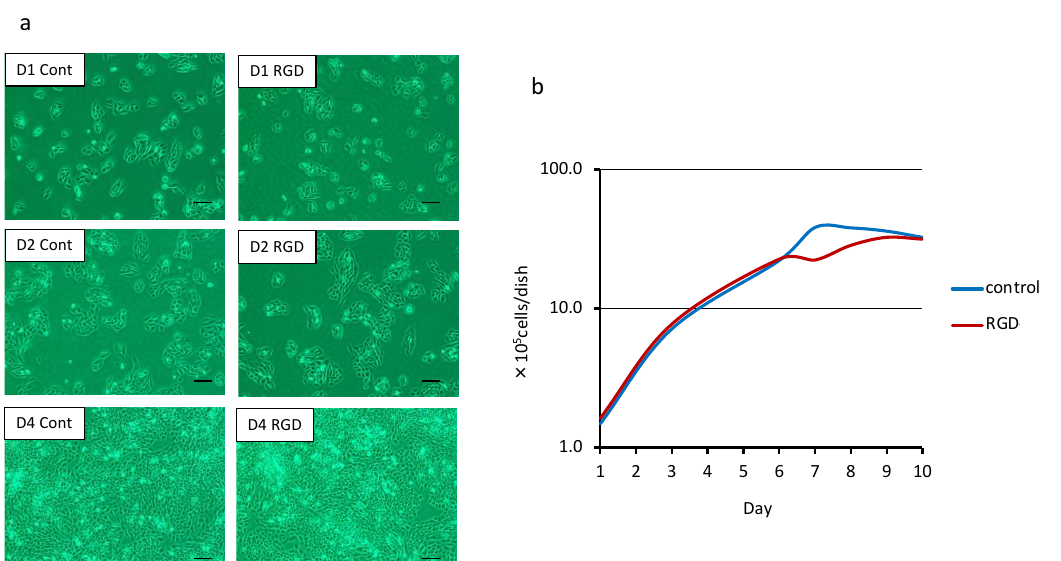
Figure 1. Cell morphology and cell number determination ( n = 3). MDPC-23 cells were cultured with the DPP-derived RGD-containing peptide. ( a ) No specific morphological changes were observed between the RGD group (RGD) and the control group (Cont) at day 1 (D1), day 2 (D2) and day 4 (D4). Bar = 150 μm. ( b ) Both groups reached confluency on day 4, and cell numbers did not show any difference between the groups either.